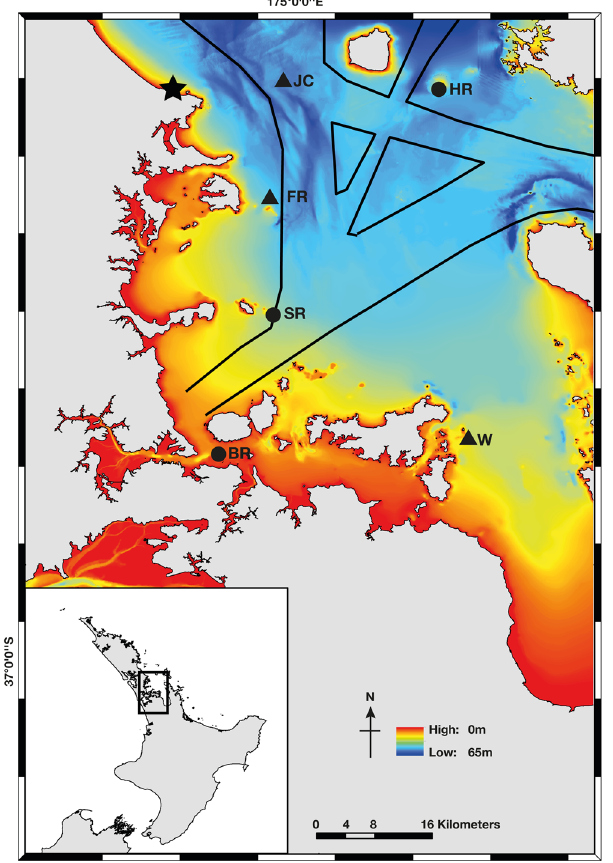
Figure 8. Map of the Hauraki Gulf, New Zealand showing the six listening stations: (clockwise from the top right) Horn Rock (HR), Waiheke Island (WI), Bean Rock (BR), Shearer Rock (SR), Flat Rock (FR) and Jellicoe Channel (JC). Circles represent diver retrieval and triangles acoustic release retrieval. The star represents the location of the Leigh Marine Laboratory weather station. Bathymetry of the area is also shown by the colour-bar from 0–65 metres and the black lines depict an outline of routes taken by vessels > 70 m in length between July 2012 and June 2013 32 . Map produced using ArcGIS 10.3.1